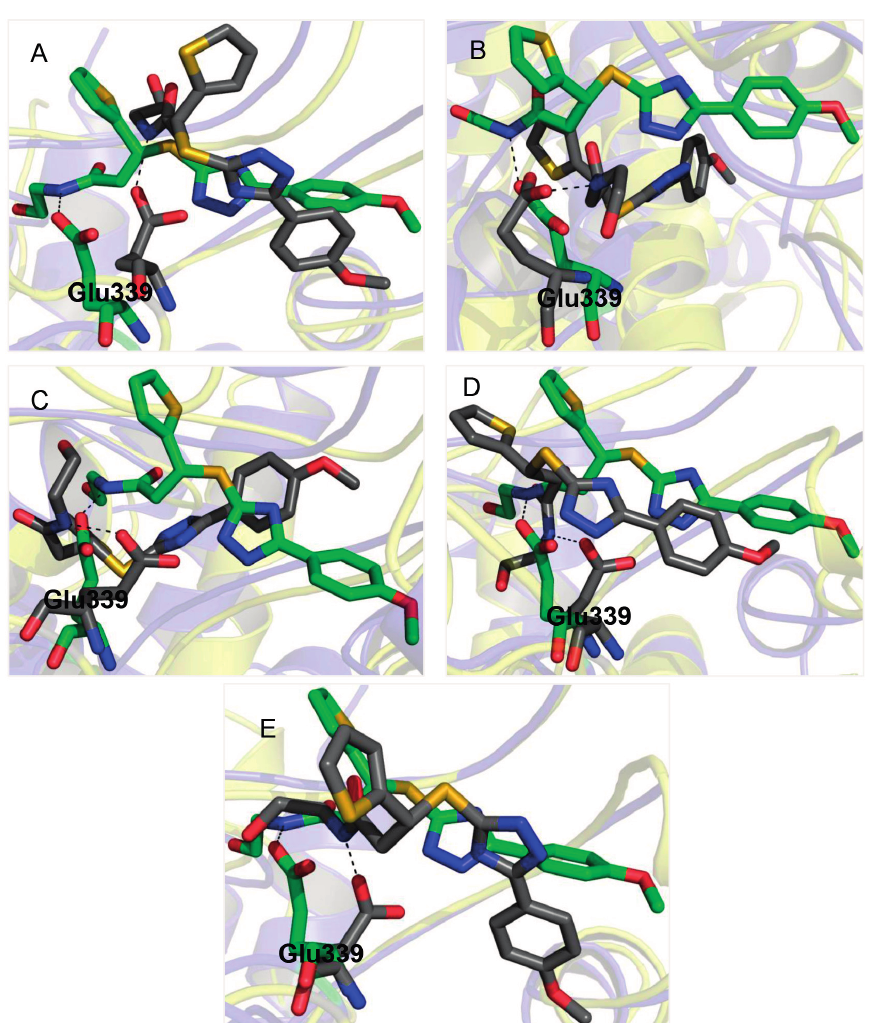
Figure 6. Binding modes of molecule A in the distinctive T-loop binding pocket conformations of NP. The ability of the molecule to interact with Glu339 in all T-loop binding pocket conformations is illustrated. The binding mode of the molecule with highest score in each conformation of the binding pocket was superimposed on that of the crystal structure. ( A – E ) represent structure 1, 2, 3, 4 and 5 superimposed on the crystal structure respectively. The crystal structure is colored in blue, MD generated structures are in yellow, carbon atoms of Glu339 and molecule A in the crystal structure are in green. Carbon atoms of Glu339 and molecule A in MD structures are colored in dark grey. Hydrogen bonds between Glu339 and molecule A are shown in black